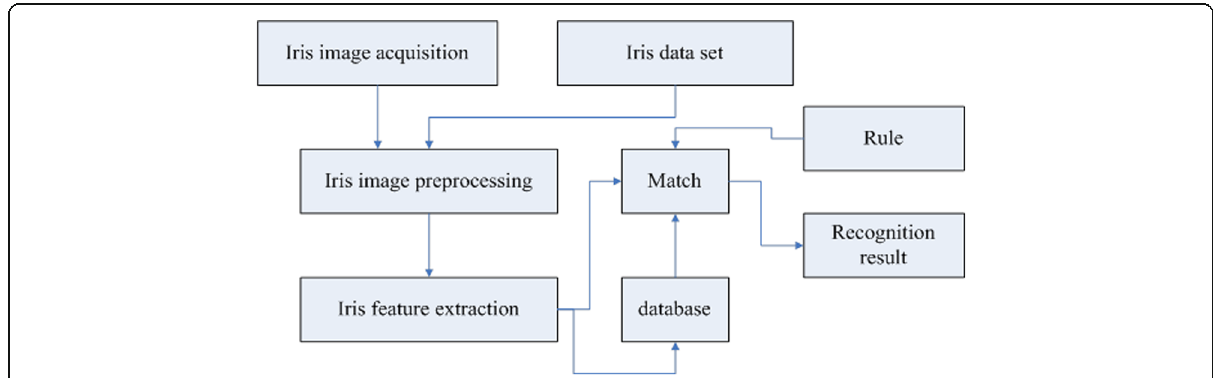
Fig. 2 Iris recognition system